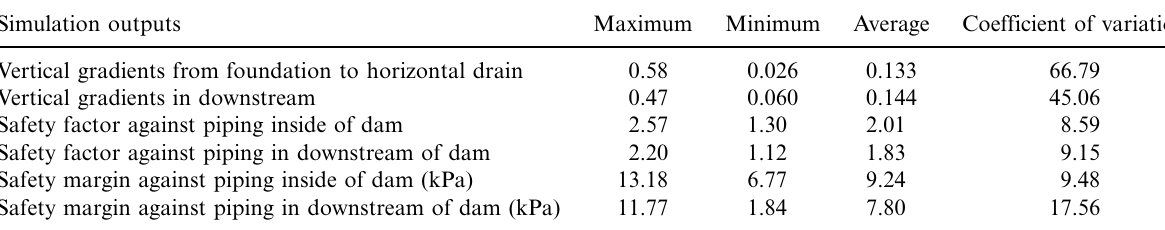
Table 4. The results of Monte Carlo finite element simulation Simulation